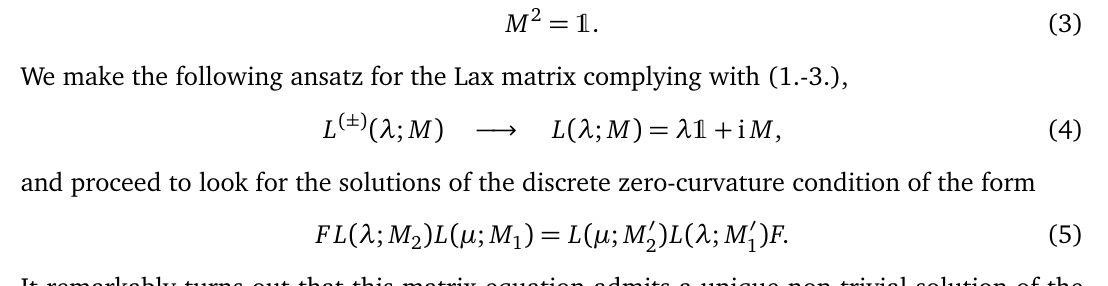
Figure 1: Elementary plaquette of the discrete light-cone lattice: matrix-valued clas- sical fields (blue circles), which belong to a certain manifold, are attached to vertices of the discrete space-time lattice. Primed variables M (cid:48) by one unit by application of propagator Φ τ . Yellow circles implement local twists of either positive or negative orientation represented by conjugations with constant invertible matrices F 1 / 2 and F − 1 / 2 ,